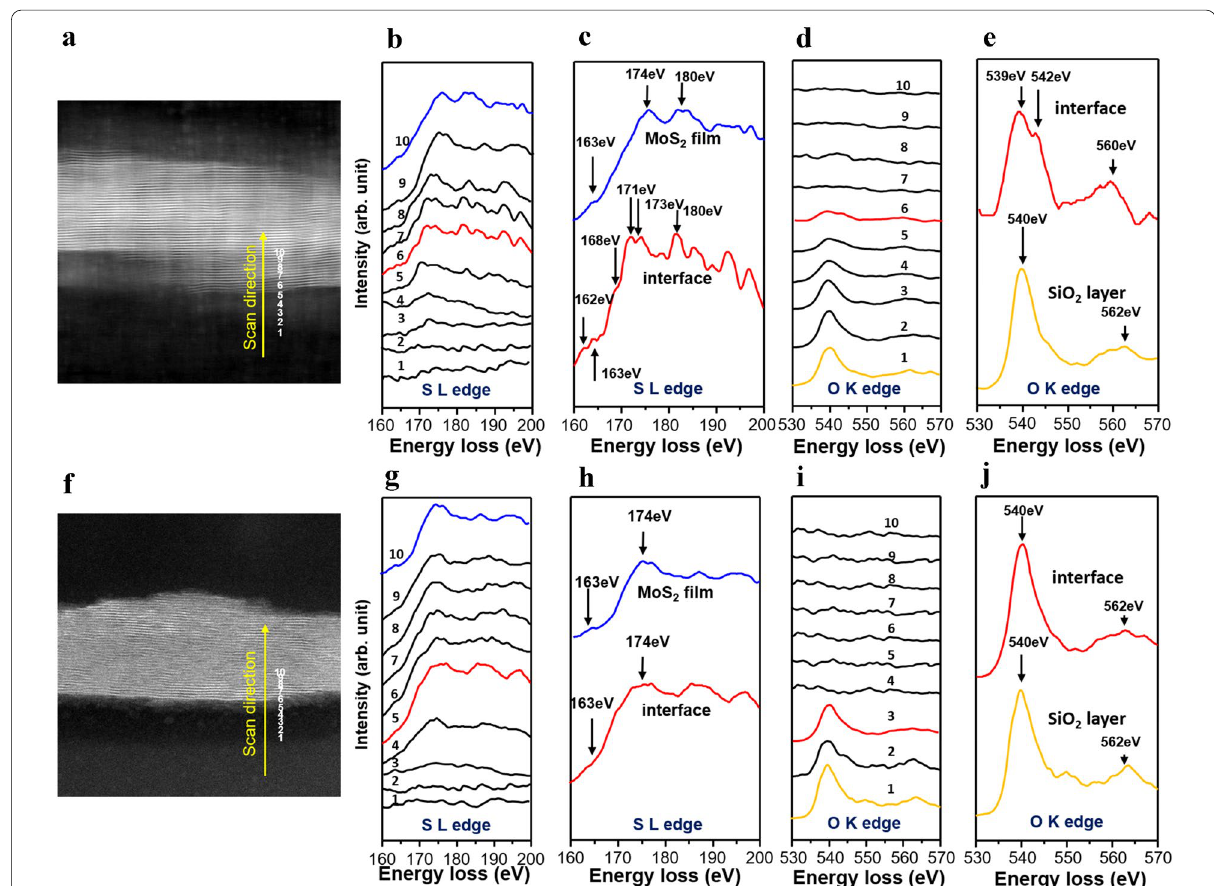
Fig. 4 a Region of AS-MoS 2 /SiO 2 in which EELS spectra were obtained. b S L-edge of the AS-MoS 2 film. c Comparison between the S L-edges of the AS-MoS 2 film (blue line) and MoS 2 /SiO 2 interface (red line). d O K-edge of the AS-MoS 2 film. e Comparison between the O K-edges of the AS-MoS 2 film (yellow line) and MoS 2 /SiO 2 interface (red line). f Region of TR-MoS 2 /SiO 2 in which EELS spectra were obtained. g S L-edge of the TR-MoS 2 film h Comparison between the S L-edges of the TR-MoS 2 film (blue line) and MoS 2 /SiO 2 interface (red line). i O K-edge of the TR-MoS 2 film. j Comparison between the O K-edges of the TR-MoS 2 film (yellow line) and MoS 2 /SiO 2 interface (red